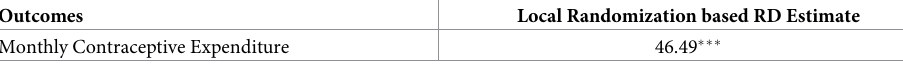
Table 7. Local Randomization-based RD estimate on the effect of UCF